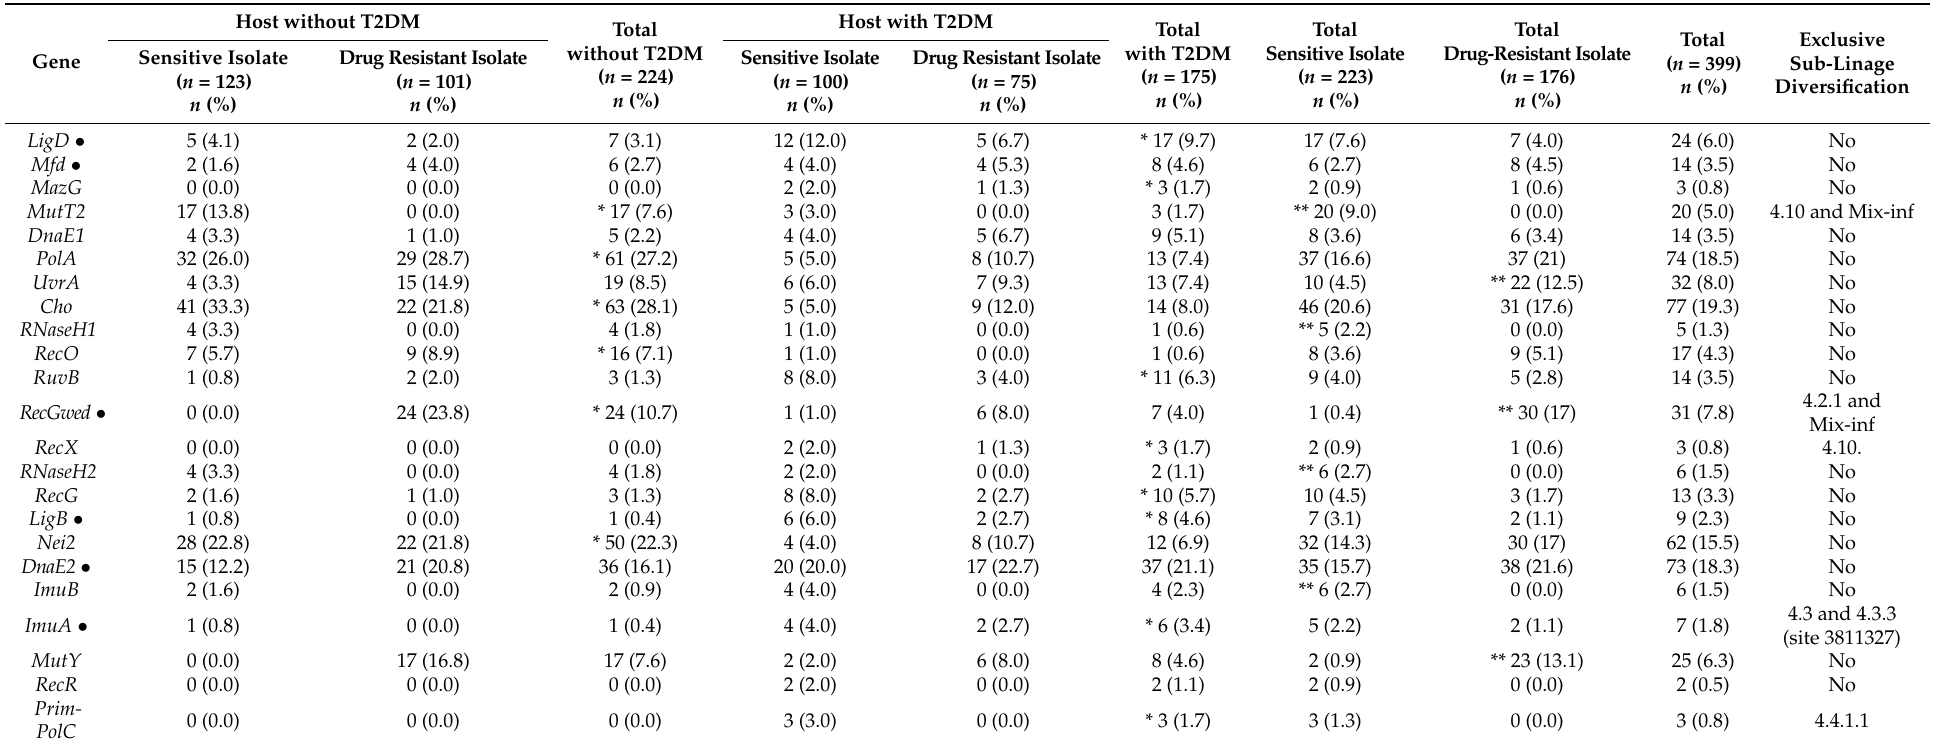
Table 3. Distribution of genes with SNPs according to drug resistance and absence/presence of T2DM in the